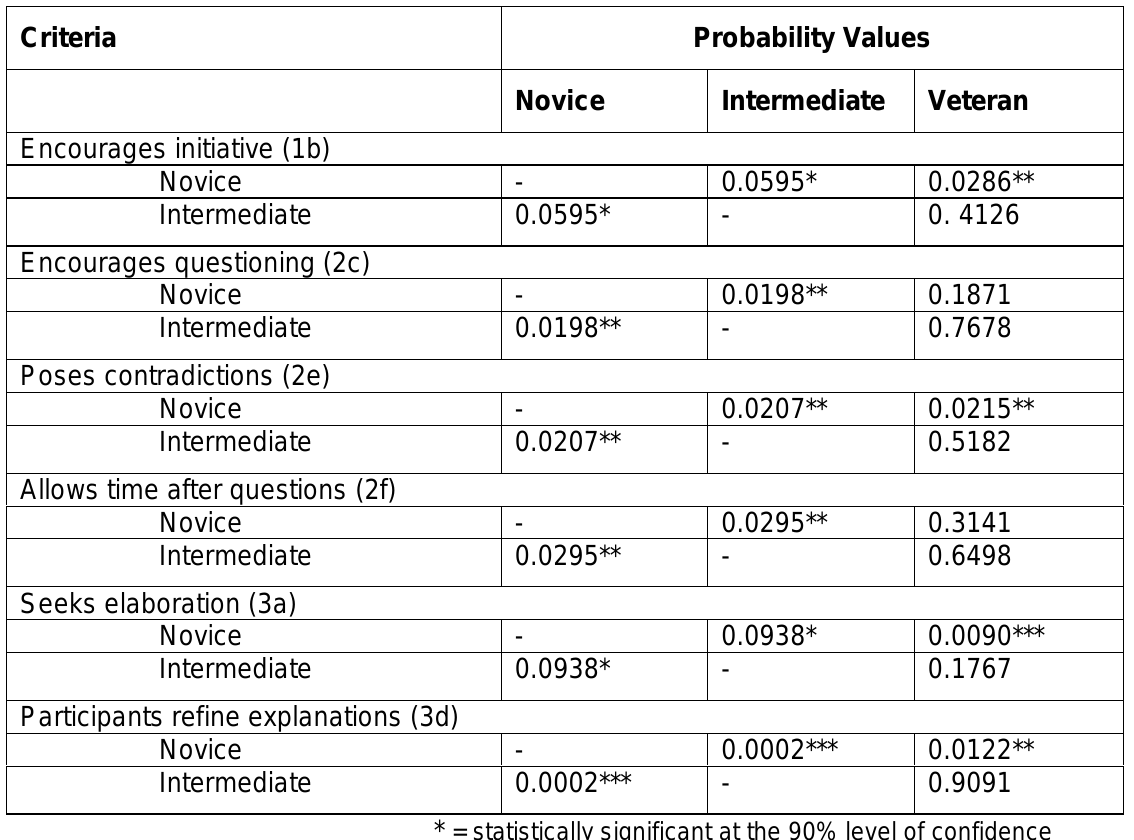
Comparison of probability values indicating statistically significant differences between facilitator mean group scores for criteria on the belief system questionnaire for inquiry